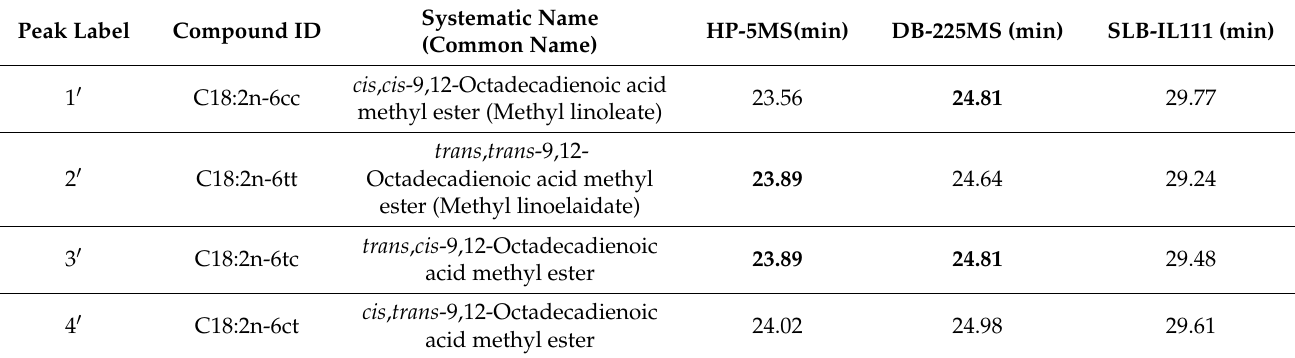
Table 2. Retention time values of FAME components in the CRM47791 mixture using the optimized methods for the three GC columns. The optimized experimental conditions are detailed in Materials and